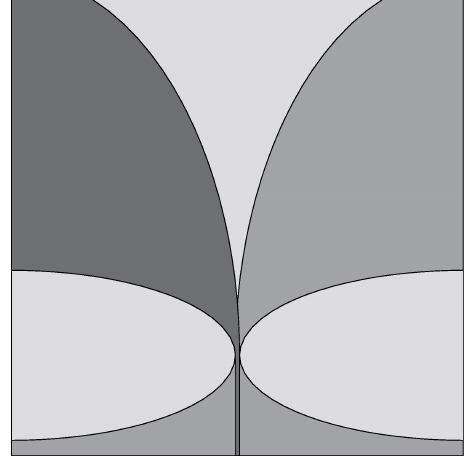
Figure 5. Design of exponentially TS-AVA (redrawn from [47]). Dark gray top metal face, medium gray bottom metal face, and light gray dielectric